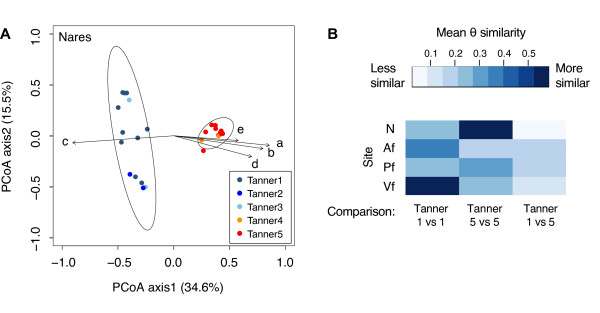
Microbial community-level statistics. (a) Nares samples clustered using principal coordinates analysis (PCoA) of the θ 'similarity' coefficient, which calculates similarity between two samples based on i) number of species in common between two samples and ii) their relative abundances. Colors represent different Tanner stages. Samples that have similar principal coordinates appear closer together, that is, are more similar. Ellipses represent the 95% confidence intervals based on standard deviation. Biplot arrows indicate the five most significant unique consensus taxonomies contributing to variation along axis 1. (Spearman correlations with axes and associated P-values are shown in Table S3 in Additional file 1). a, Propionibacterium; b, Corynebacterium; c, Streptococcus; d, Turicella; e, Anaerococcus. Additional skin sites are shown in Figure S2 in Additional file 2. (b) Heatmap of mean θ similarity coefficients of pairwise comparisons of communities within or between individuals of Tanner stage 1 and Tanner stage 5 (within-group, Tanner 1 versus Tanner 1 or Tanner 5 versus Tanner 5; between-group, Tanner 1 versus Tanner 5). Darker color indicates higher similarity: θ = 0 indicates that two samples have no species in common and θ = 1 indicates that two samples are identical. Site abbreviations: Af, antecubital fossa; N, nares; Pf, popliteal fossa; Vf, volar forearm.